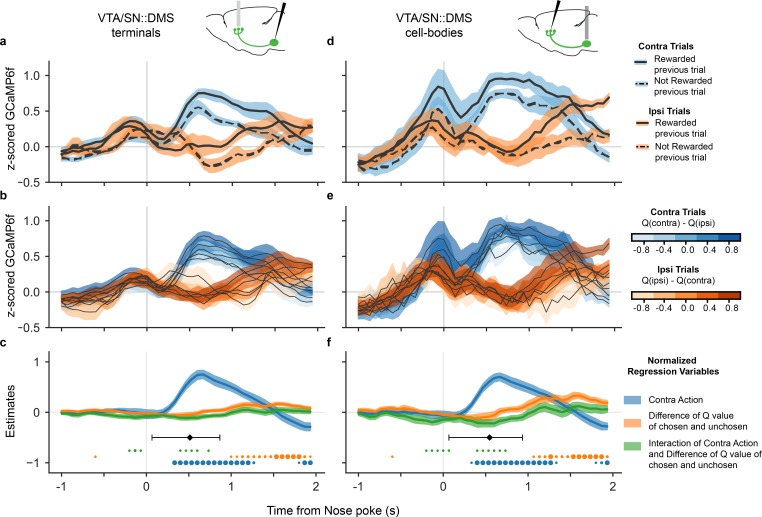
Analysis of DA signals time-locked to nose poke.(a) GCaMP6f signal time-locked to nose poke for contralateral trials (blue) and ipsilateral trials (orange), as well as rewarded (solid) and non-rewarded previous trial (dotted) from VTA/SN::DMS terminals. Colored fringes represent ±1 standard error from activity averaged across recording sites (n = 12). (b) GCaMP6f signal for contralateral trials (blue) and ipsilateral trials (orange), and further binned by the difference in Q values for chosen and unchosen action. Colored fringes represent ±1 standard error from activity averaged across recording sites (n = 12). (c) Mixed effect model regression on each datapoint from 3 seconds of GCaMP6f traces. Explanatory variables include the action of the mice (blue), the difference in Q values for chosen vs unchosen actions (orange), their interaction (green), and an intercept. Colored fringes represent ±1 standard error from estimates (n = 12 recording sites). Black diamond represents the average latency for lever presentation from nose poke, with the error bars showing the spread of 80% of the latency values. Dots at bottom mark timepoints when the corresponding effect is significantly different from zero at p<0.05 (small dot), p<0.01 (medium dot), p<0.001 (large dot). P values were corrected with Benjamini Hochberg procedure. (d-f) Same as (a-e), except with signals from VTA/SN::DMS cell bodies averaged across recording sites (n = 7) instead of terminals.